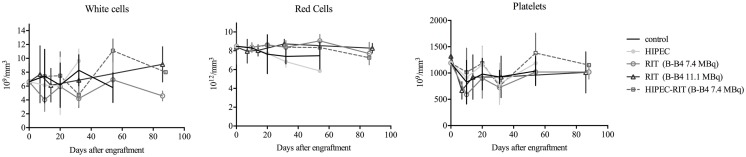
Measurement of blood cell counts according to treatment groups. This figure shows the average changes in red blood cell levels, leukocytes, and platelets as a function of time (days after engraftment) and treatment group.